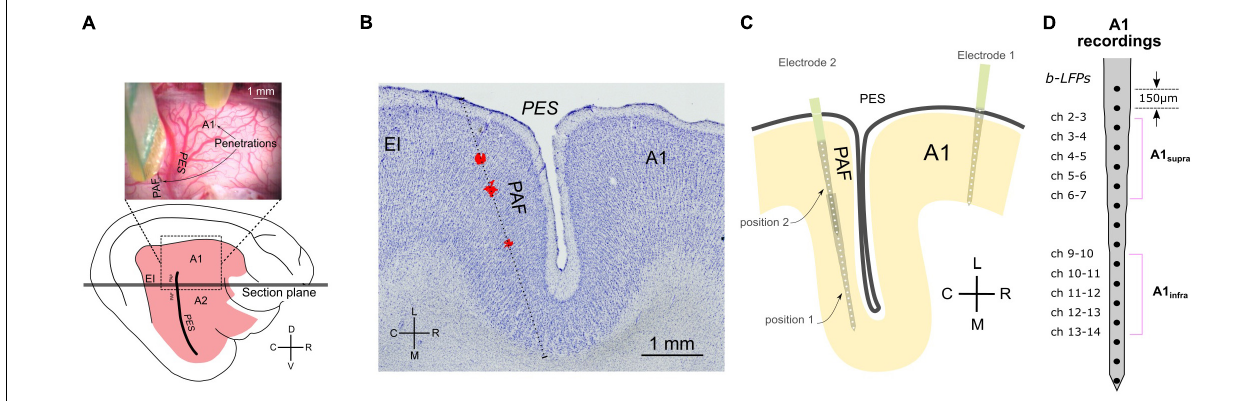
FIGURE 1 | Methodology and recording positions. (A) Top: photograph of feline cortex after trephination, revealing the penetration sites in A1 and PAF. Bottom: illustration of entire brain from the same perspective. (B) Reconstruction of penetration of the DiI stained probe in a Nissl-stained section. The sectional plane is shown in (A) . The stained images were stacked and aligned to reconstruct the penetration. The red deposits shown (DiI) were extracted from several successive florescence images from the same region of the cortex and projected onto the Nissl-stained section. The reconstructed direction of penetration is shown as a dotted line. (C) Schematic illustration of electrode penetrations in A1 and PAF. In PAF, dense mapping allowed capture of auditory responses in each animal. Using two recording depths, each penetration includes 32 recording sites in total. (D) Channels of bipolar derivation LFP (b-LFP) in A1 recordings, grouped into supragranular (A1 supra ) and infragranular (A1 infra ) layers. A1, primary auditory cortex; EI, intermediate area of the posterior ectosylvian gyrus; PAF, posterior auditory field; PES, posterior ectosylvian sulcus; V, ventral; D, dorsal; R, rostral; C, caudal; L, lateral; M,